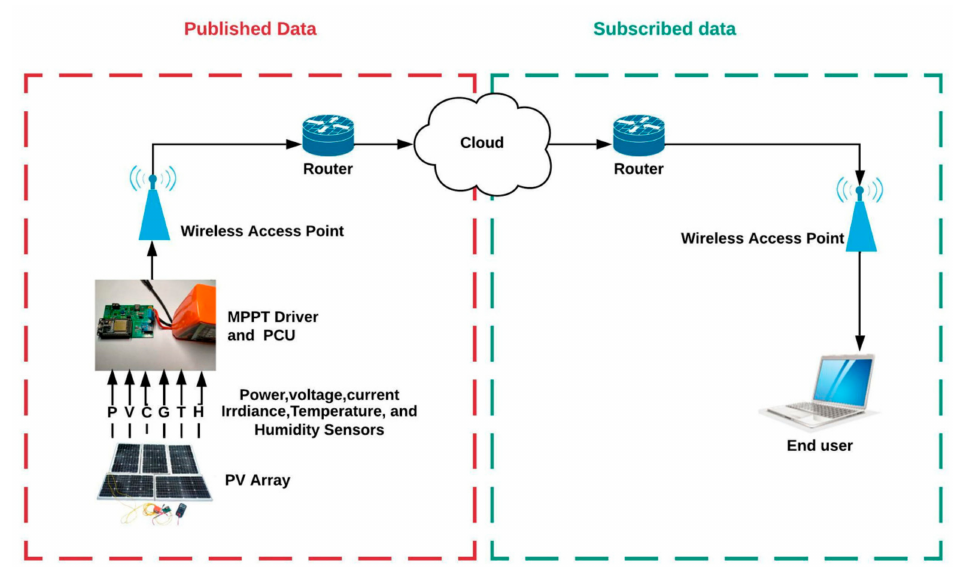
Figure 1. Structure of the real-time monitoring